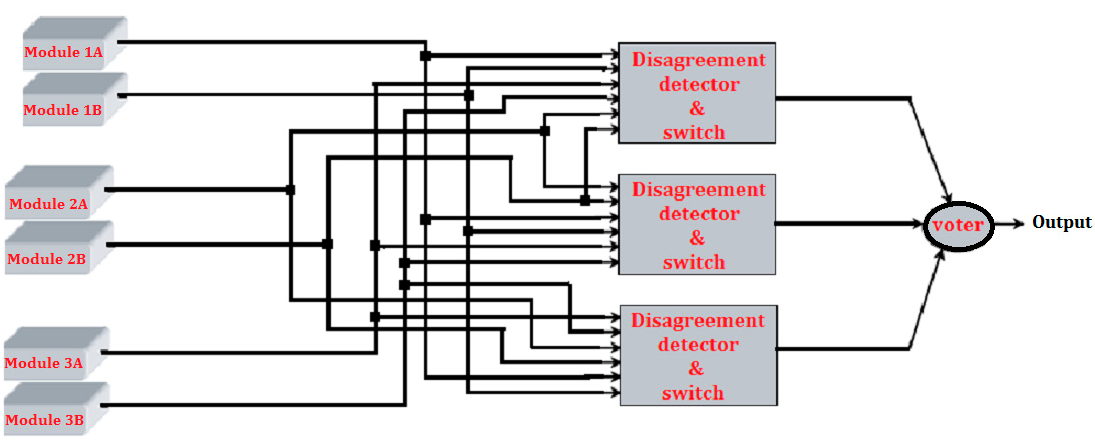
Figure 1. Modified triplex–duplex Redundancy.